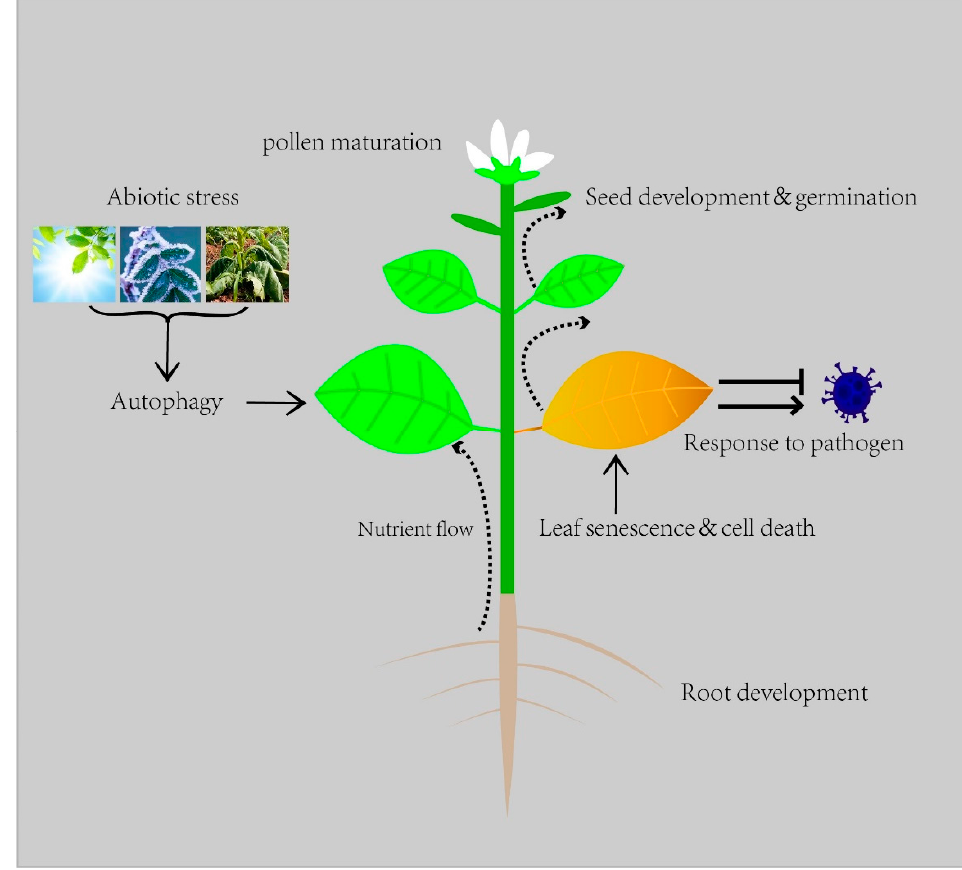
Figure 1. Autophagy in plant